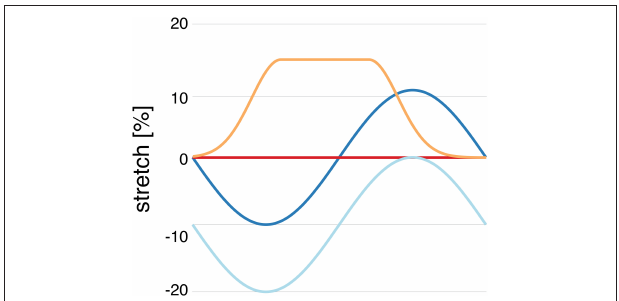
FIGURE 1 | Myocyte stretch protocols. Stretch pattern H (light blue) approximates normal isotonic myocyte shortening with a sinusoidal function. Protocol I (red) is sarcomere isometric contraction. Protocol S (dark blue) simulates late systolic stretch by shifting the sine wave upwards. Protocol P (orange) simulates systolic lengthening such as occurs in acutely ischemic